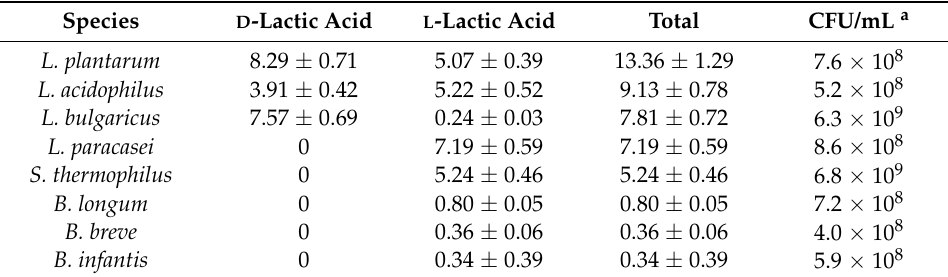
Table 2. Lactic acid production by probiotic